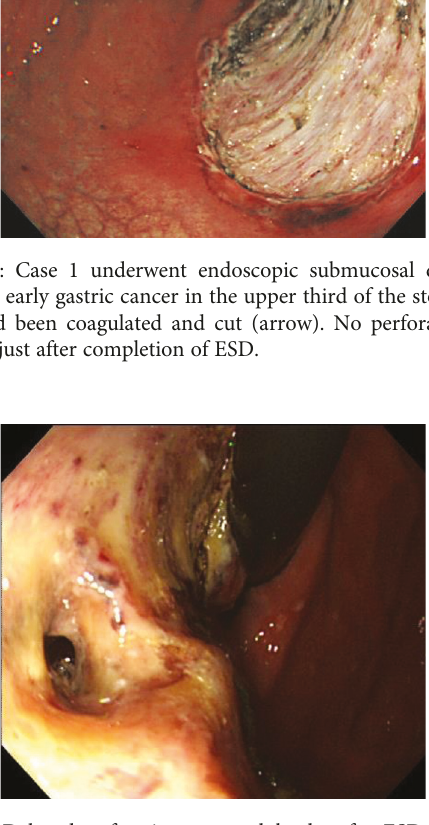
Figure 2: Delayed perforation occurred the day after ESD. Duration of cautery needed for hemostasis in this perforated points was a total of 11 s.